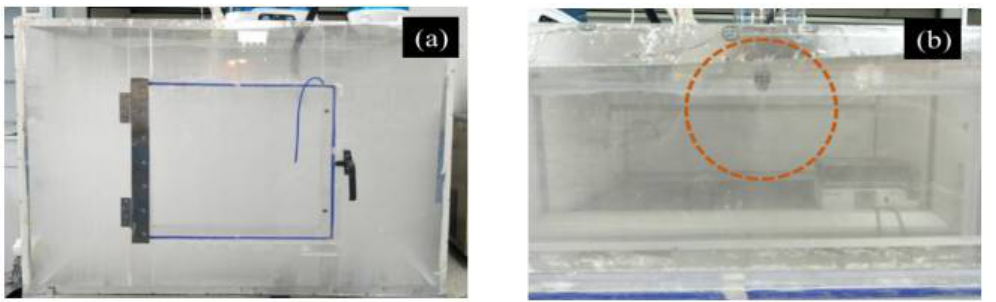
Figure 12. Simulated aerosol device: ( a ) simulation box filled with aerosol; ( b ) spraying effect of the atomizing nozzle.